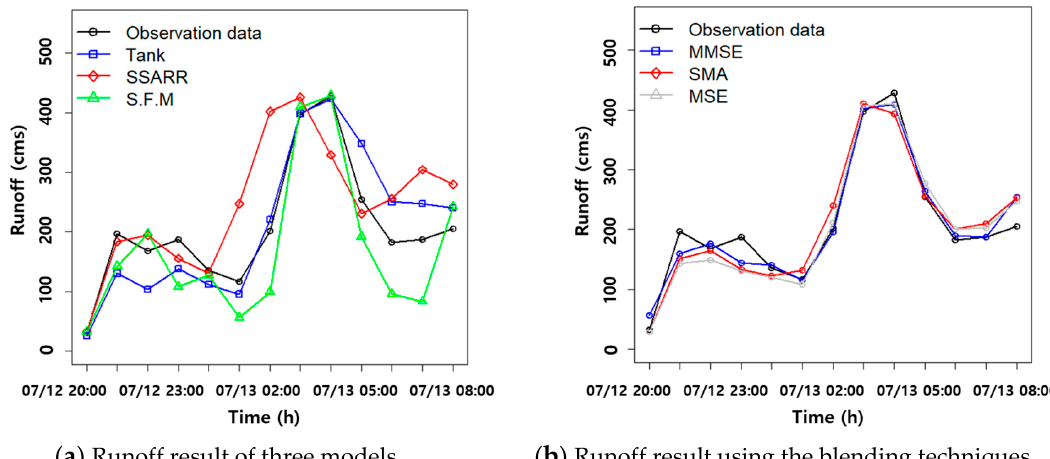
Figure 12. Runoff hydrograph using the radar data.